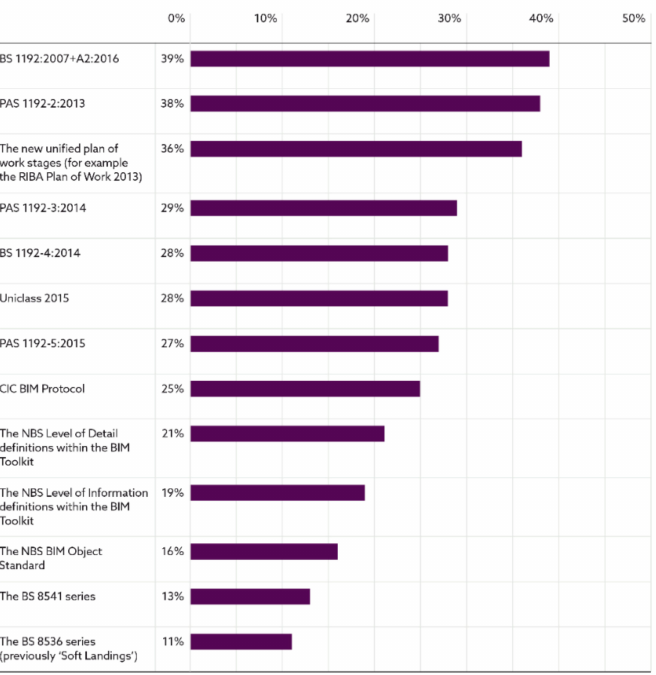
Figure 2. Responses to the question “Which of the following standards/publications does your organisation use?” in the NBS BIM Report